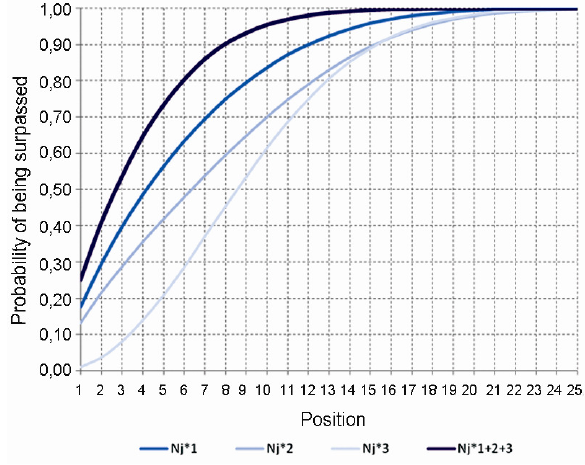
Fig. 5. Position performance of several